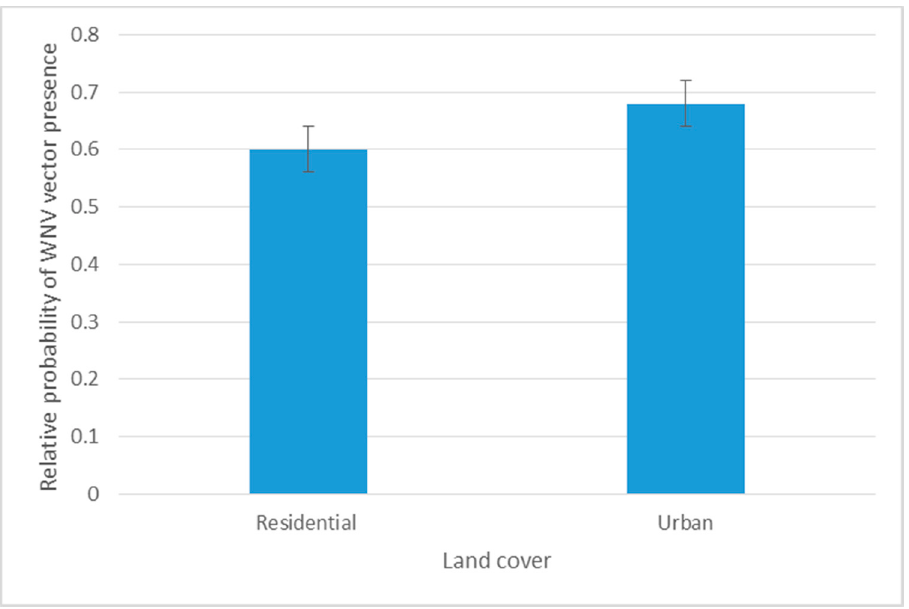
Figure 5. Response curve of spatial distribution of VHC ratio to predicting variables in the Jackknife test.